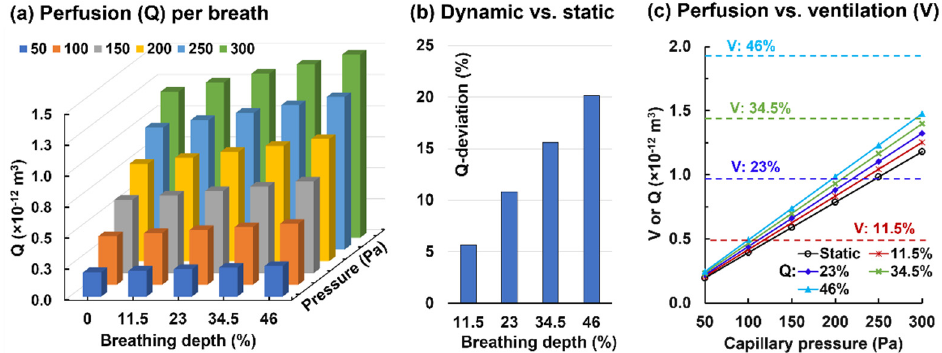
Figure 7. Alveolar perfusion: ( a ) the alveolar perfusion (×10 − 12 m 3 ) integrated over one breathing cycle at varying capillary pressures and breathing depths, ( b ) the perfusion rate deviation from the static case vs. breathing depth, and ( c ) perfusion (Q) vs. ventilation (V).